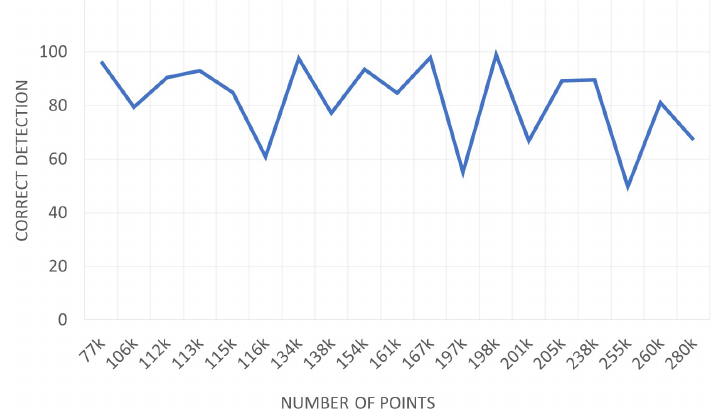
Figure 7. Correct detection metric difference according to the number of points. It can be seen that there is not much change in performance depending on the number of